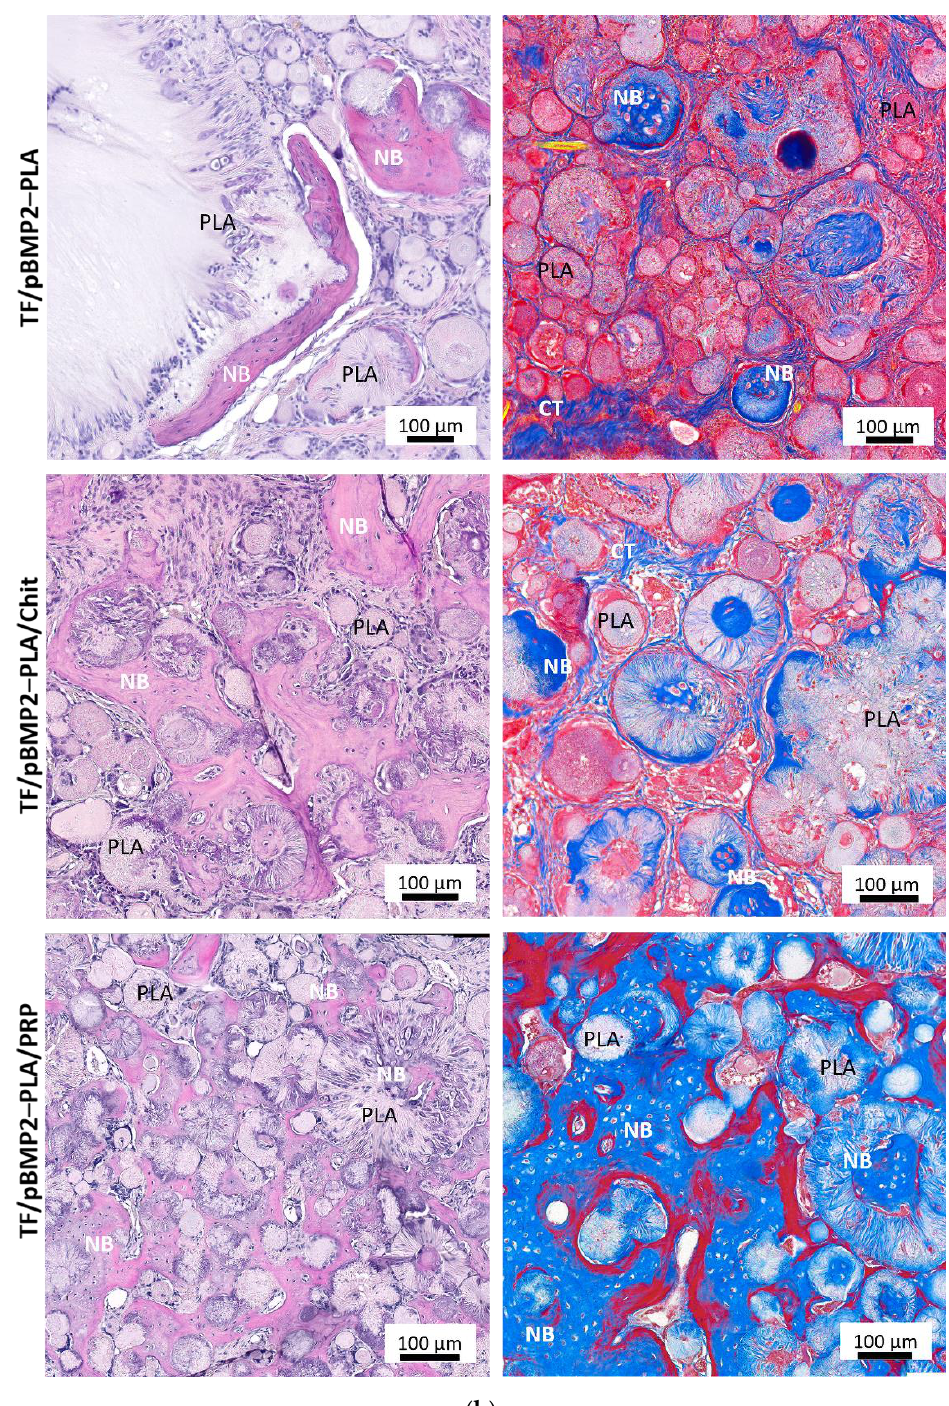
Figure 7. Critical-size calvarial bone defect regeneration 56 days after implantation of the matrices: ( a ) nonactivated matrices; ( b ) TF/BMP2-Matrices. H&E and Masson ’ s trichrome staining. Light microscopy. CT — connective tissue, NB — newly formed bone.